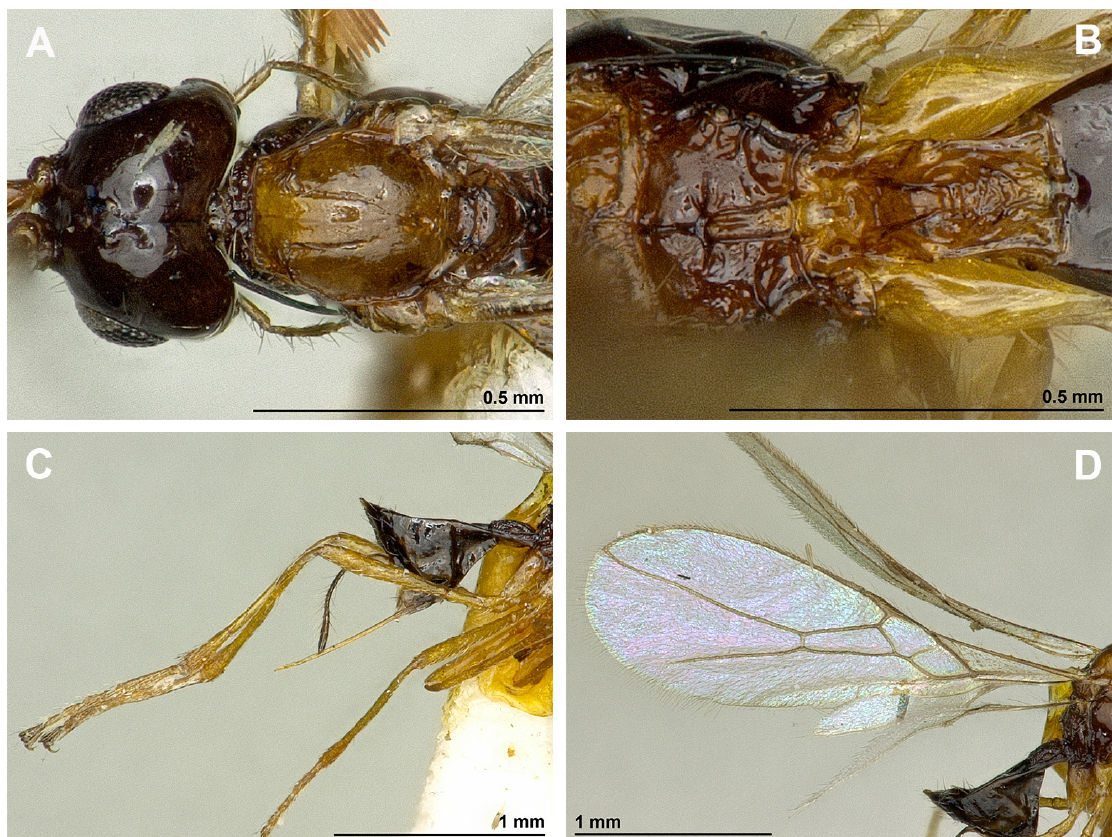
Fig. 18. Asobara fletcheri Peris-Felipo, sp. nov., ♀, holotype (BMNH 1952-566). A . Head and mesoscutum, dorsal view. B . Propodeum and first metasomal tergite, dorsal view. C . Hind leg, metasoma and ovipositor, lateral view. D . Fore and hind